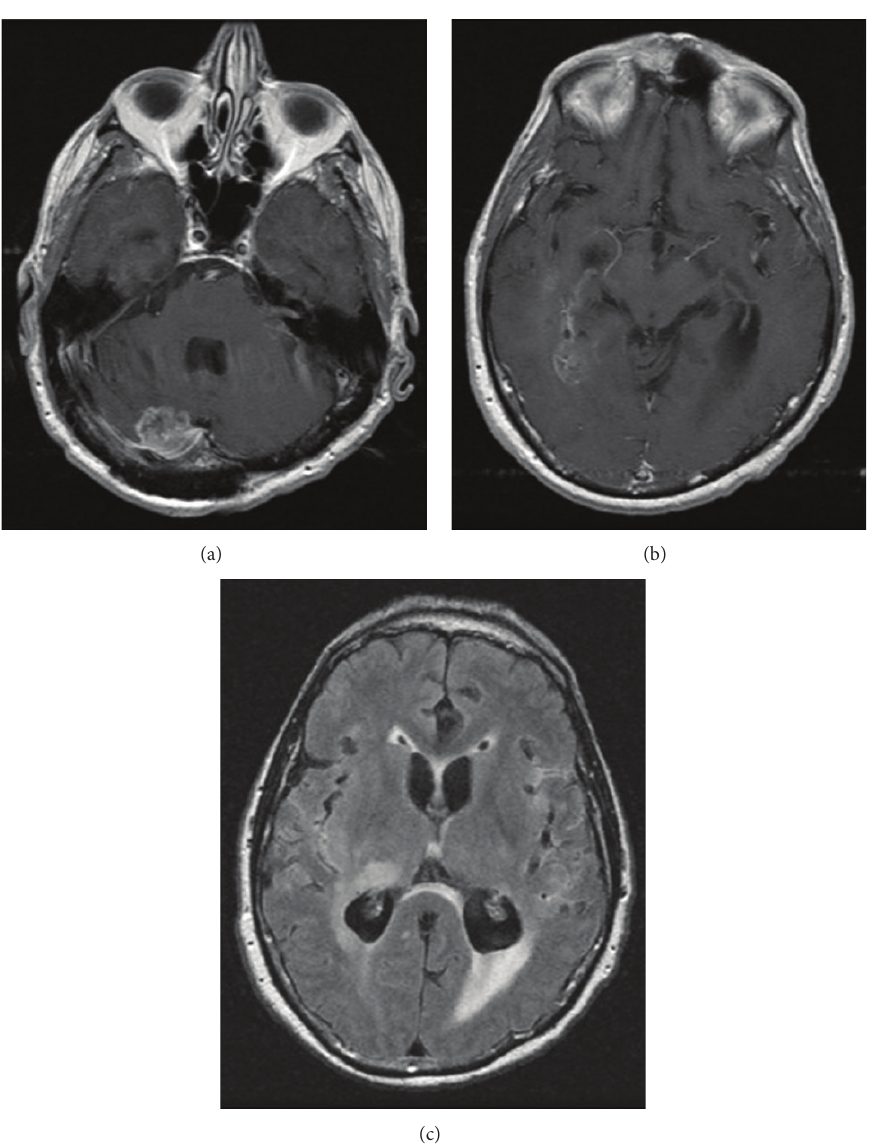
Figure 4: Postoperative MR imaging. (a) Axial T1-weighted image with contrast at the level of the cerebellum displaying subtotal resection of the tumor within the right cerebellar hemisphere. (b) Axial T1-weighted image with contrast at the level of the Sylvian fissures showing leptomeningealenhancement.(c)AxialFLAIRimageabovethetentoriumrevealingdiffuseFLAIRsignalabnormalitywithinbilateralcerebral